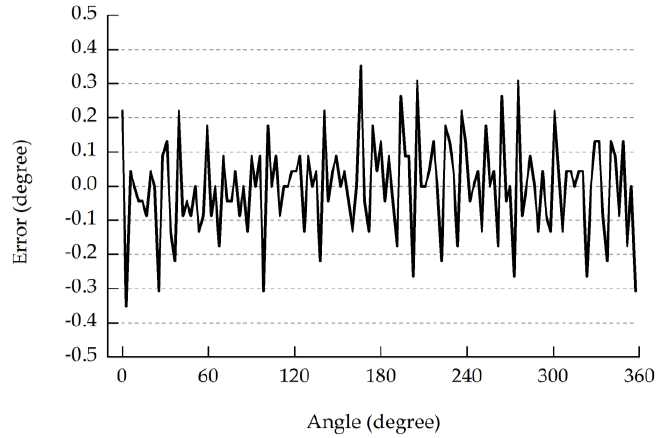
Figure 11. Error of the outputs of the prototype.